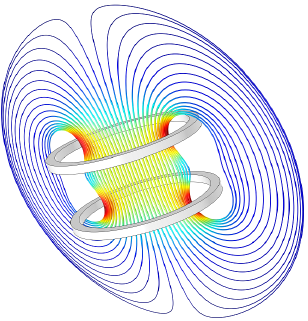
Figure 8. Magnetic field (Helmholtz coils).